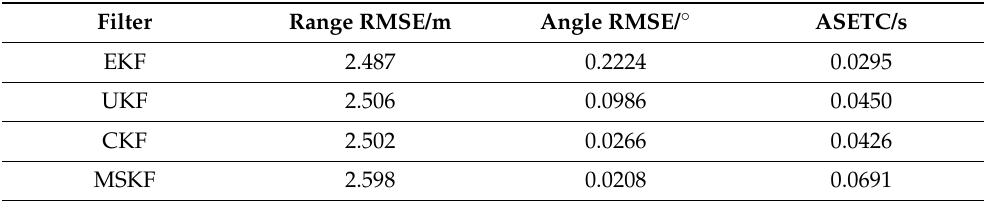
Table 1. Different filtering accuracy and time consumption in scenario (1). Filter Range